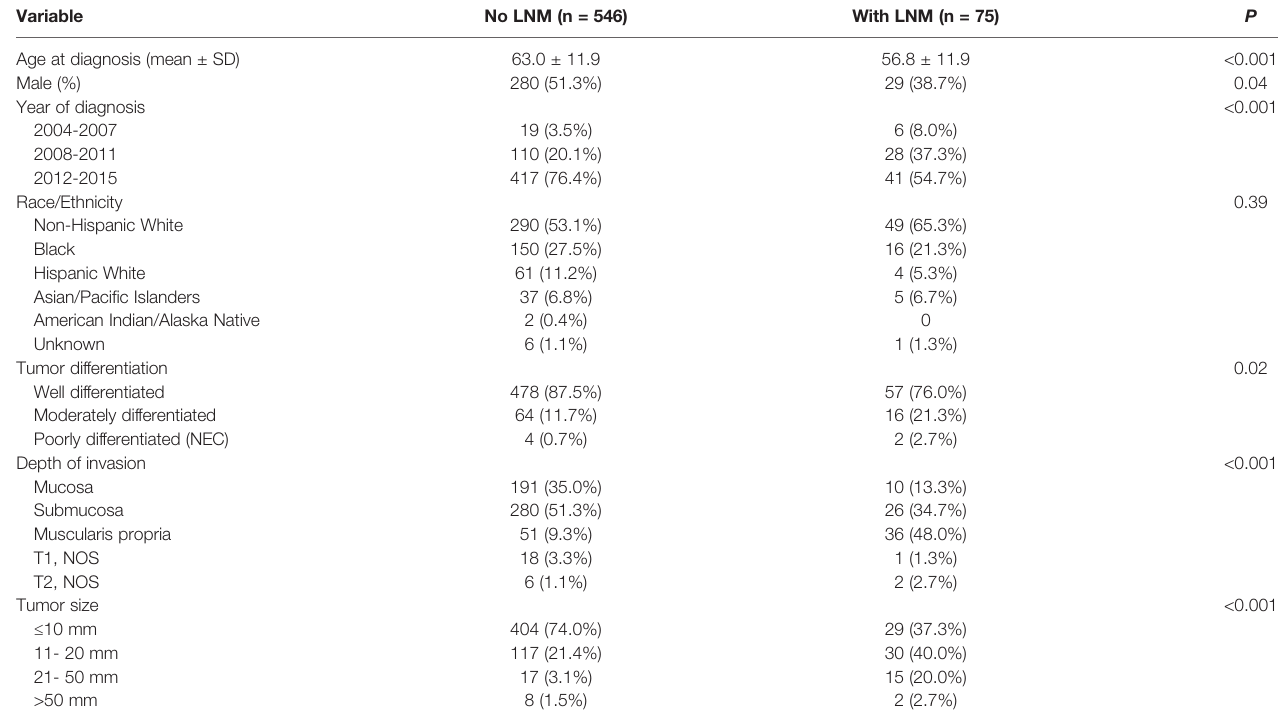
TABLE 2 | Characteristics of patients with T1/T2 d-NENs (n = 621) with and without LNM. Variable Age at diagnosis (mean ± SD)